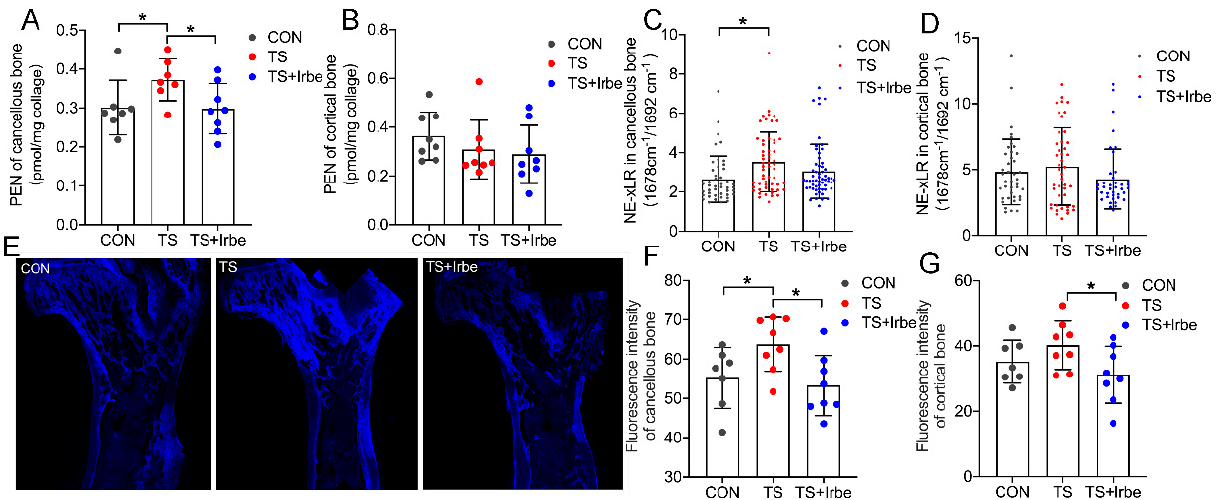
Figure 1. Irbesartan inhibited AGEs accumulation in bone matrix after tail suspension. ( A ) PEN content of cancellous bone. ( B ) PEN content of cortical bone. ( C ) NE − xLR in cancellous bone. ( D ) NE − xLR in cortical bone. I Spontaneous fluorescence images of bone slices. ( E ) spontaneous fluorescence images. ( F ) Fluorescence intensity of cancellous bone. ( G ) Fluorescence intensity of cortical bone. Values are all expressed as mean ± SD. * p < 0.05.